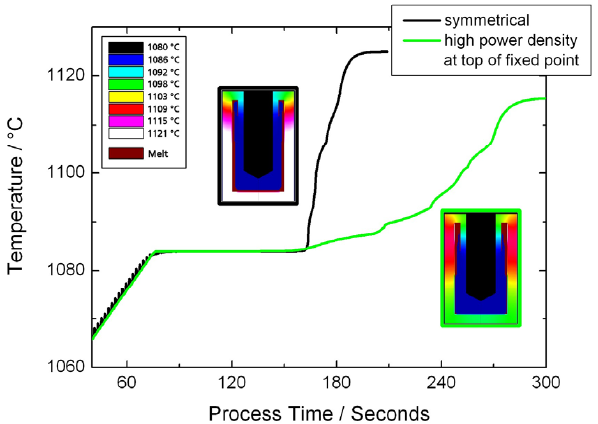
Figure 6. FEM simulation of temperature field across a fixed-point cell after induction heating (variation of induction frequency: left, 125kHz; middle, 250kHz; and right, 1000kHz).